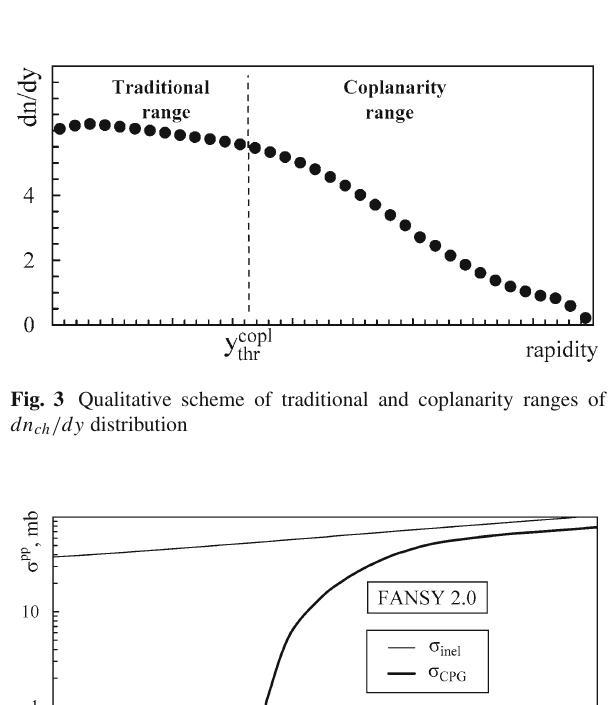
Fig. 2 Tracksofparticles,generatedinthesameinteraction,onatarget plane in cases of traditional particle generation (left), coplanar particle generation within the primary concept of increased p t (middle) and coplanar particle generation within the new concept of traditional p t (right). Most energetic particles are shown with large filled circles